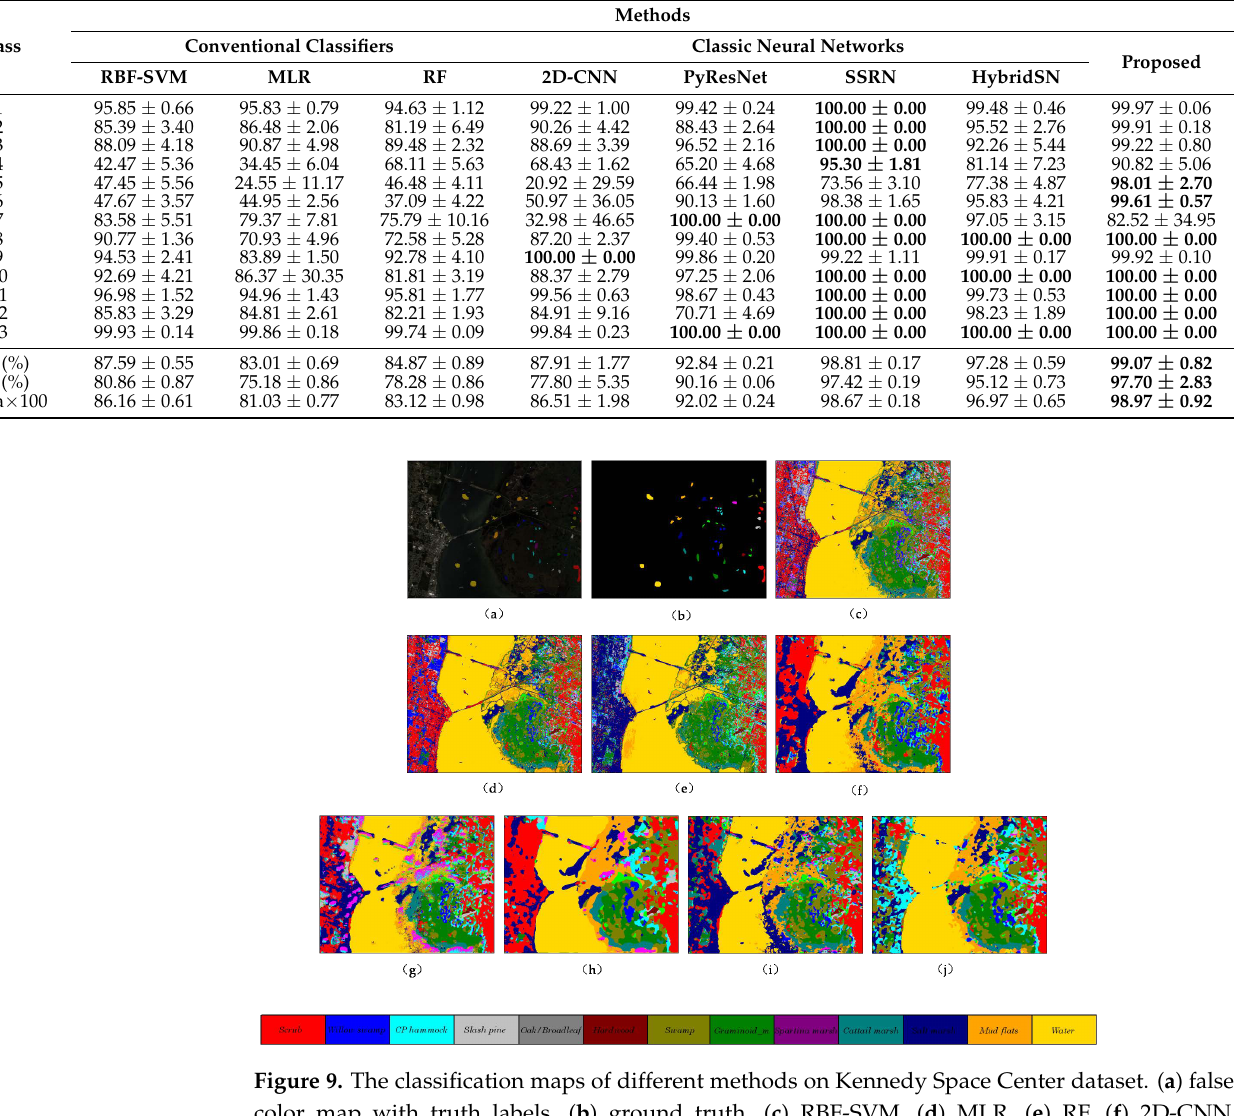
Table 6. The categorized results of different methods on the Kennedy Space Center dataset.